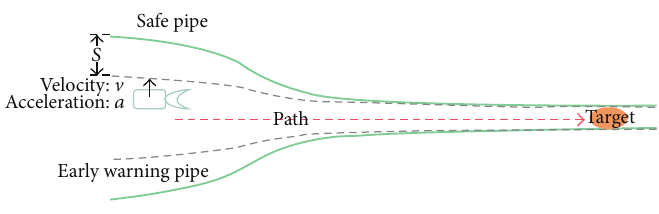
Figure 3: Result of dynamic early warning pipes adjustment.